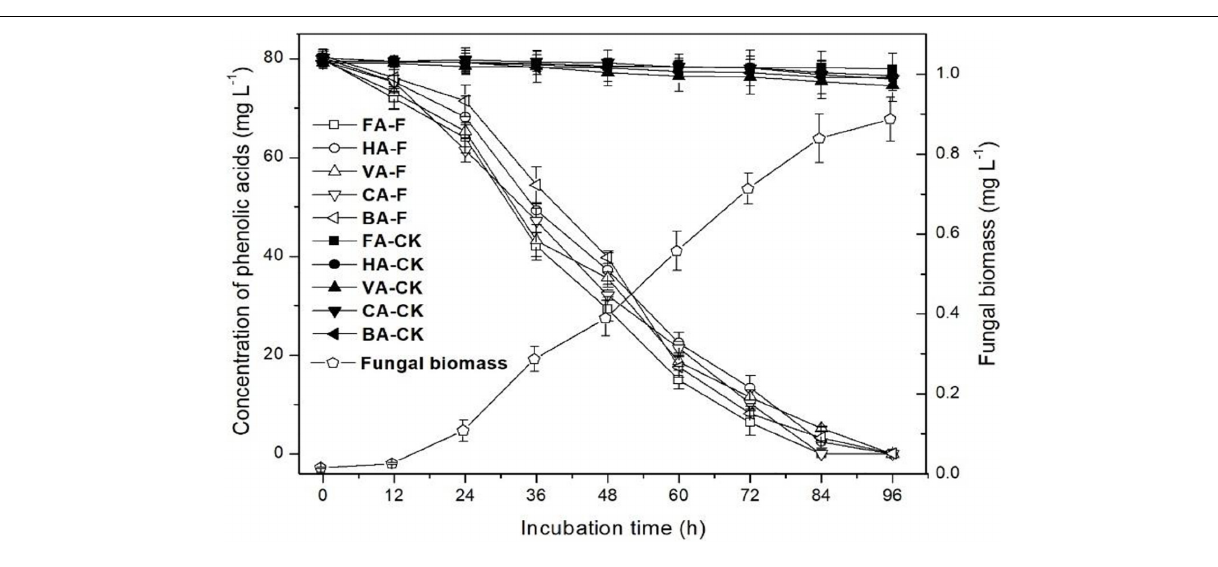
FIGURE 6 | Degradation efficiency of mixture of phenolic acids by P. ostreatus P5. HA, p -hydroxybenzoic acid; VA, vanillic acid; FA, ferulic acid; CA, p -coumaric acid; BA, benzoic